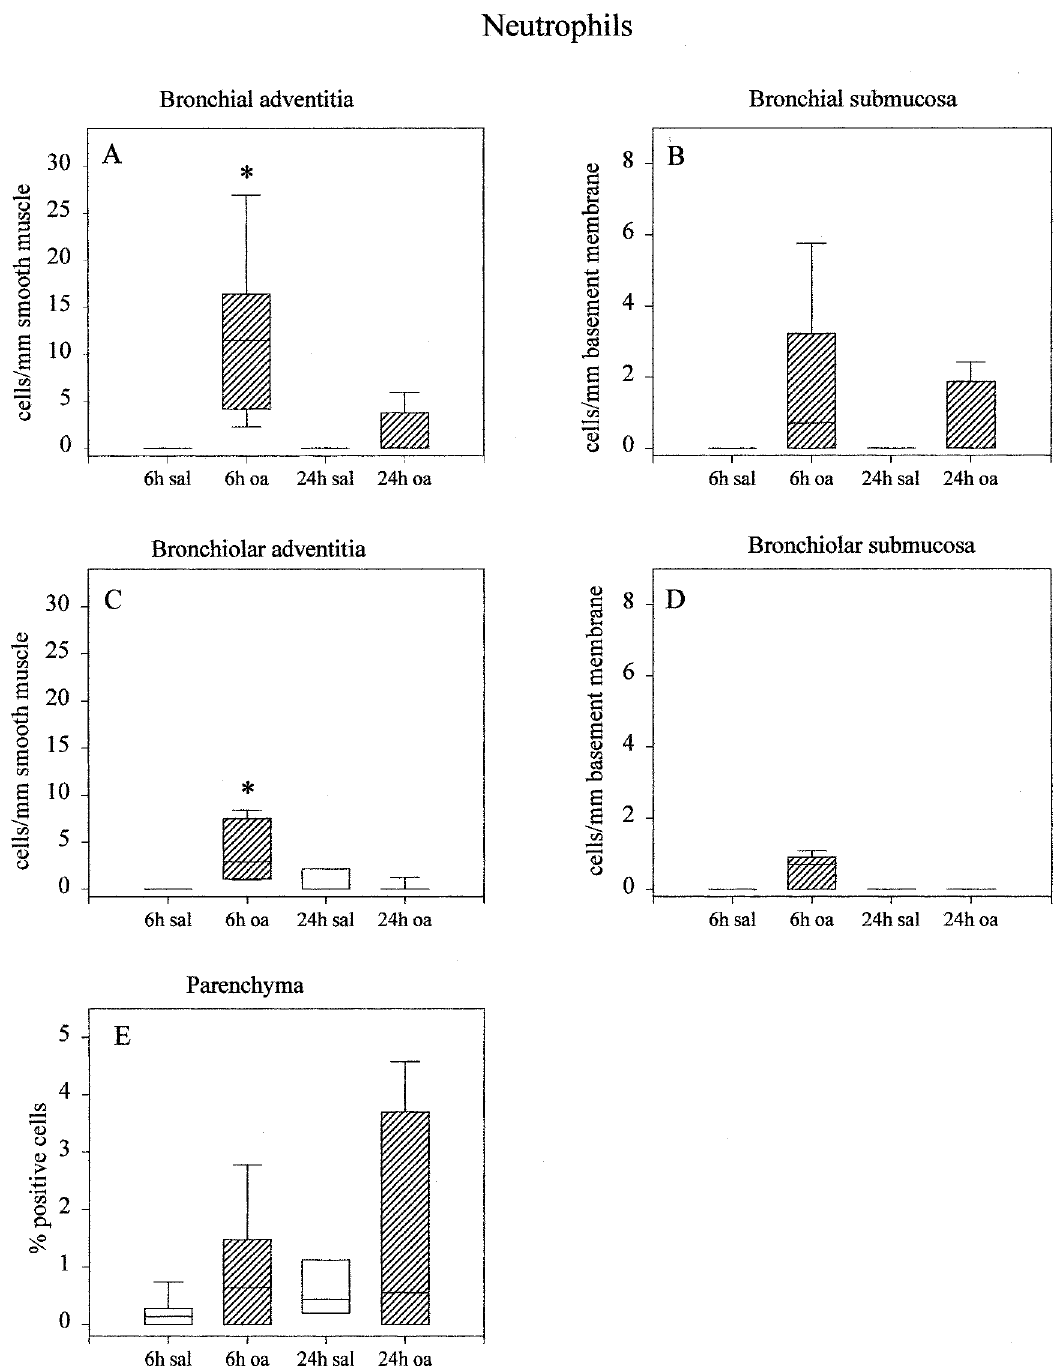
FIG. 4. Neutrophil numbers at 6 and 24h after saline control inhalation (sal, open bars) or ovalbumin inhalation (oa, hatched bars) in different airway compartments. Data represent median values, interquartiles, and 10th and 90th percentiles of four to six animals. Statistical analysis: * p < 0.01, Mann–Whitney rank sum